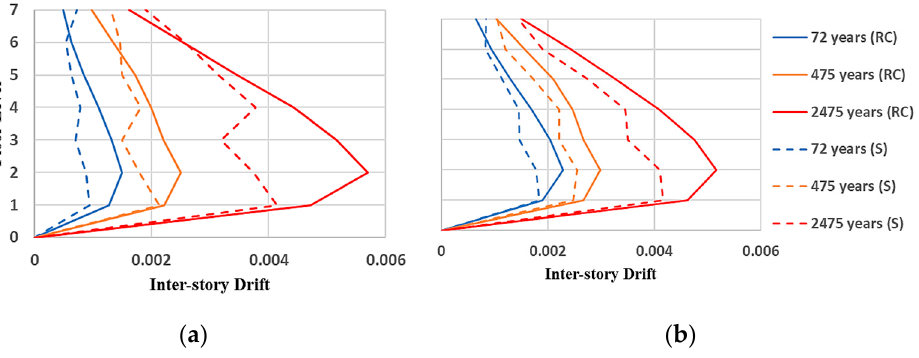
Figure 10. ( a ) Agua Prieta, Sonora, ( b ) Guadalajara, Jalisco. Mean of the maximum inter-story drift response for each level of the steel and reinforced concrete structural model for seismic zone C.